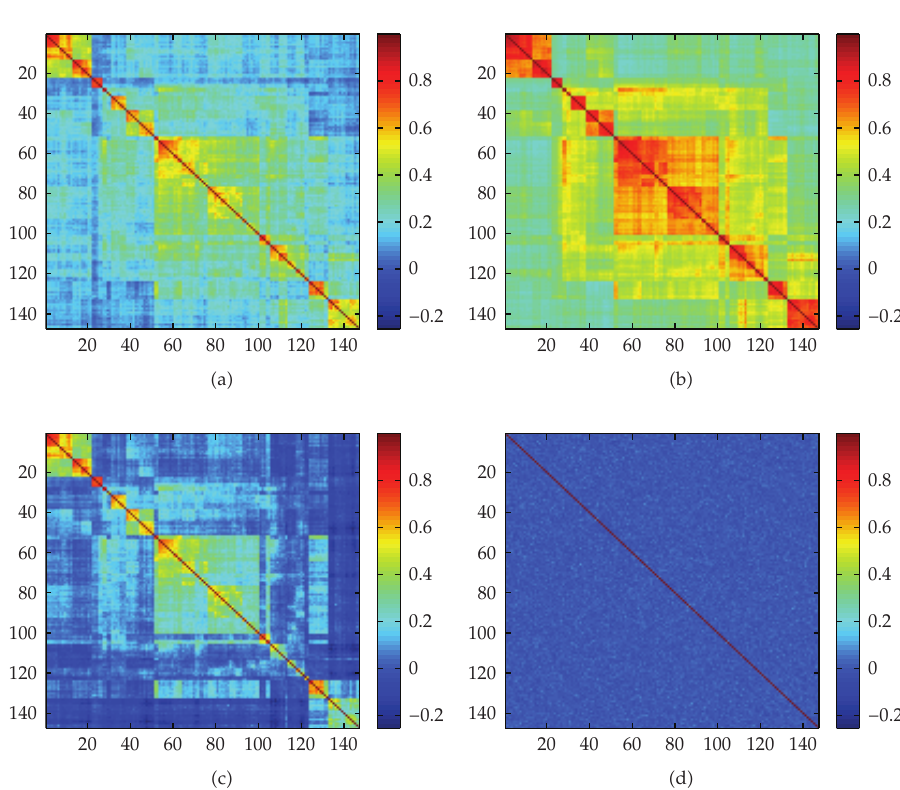
Figure 1: Raw correlation (cid:3) a (cid:4) , a ffi nity (cid:3) b (cid:4) , and partial correlation (cid:3) c (cid:4) matrices of a representative set of 147 stocks from the S&P dataset. A random matrix (cid:3) d (cid:4) is created using size similar properties.